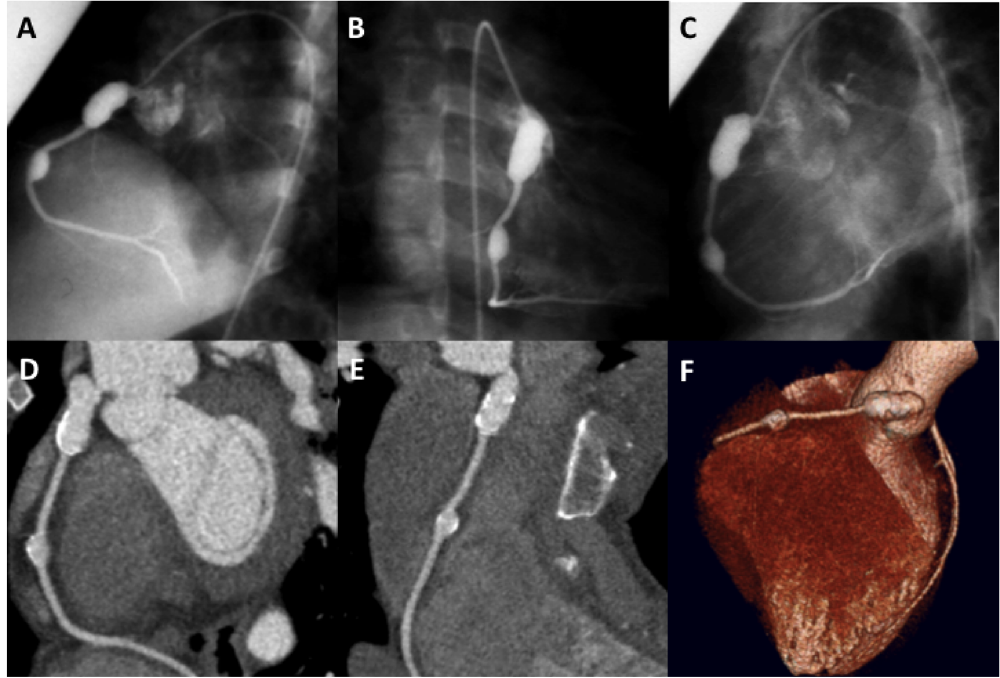
Figure 6. Cardiac CT vs catheter correlation. A-C) Conventional angiographic views display 2 giant aneurysms in theRCA.D,E)Curvedmultiplanar reformatsfrom cardiacCT datasetdemonstrate good correlationand moreclearly depictwallcalcificationandlackofmuralthrombus.F)Volume-renderedimagefromacardiacCTdatasetrepresents an alternative visual method for displaying CT findings.